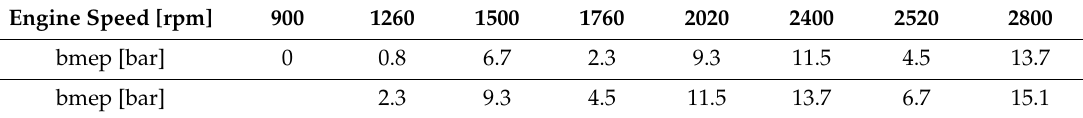
Table 8. DW10 engine operation points tested with B70 fuel (see Table 7).